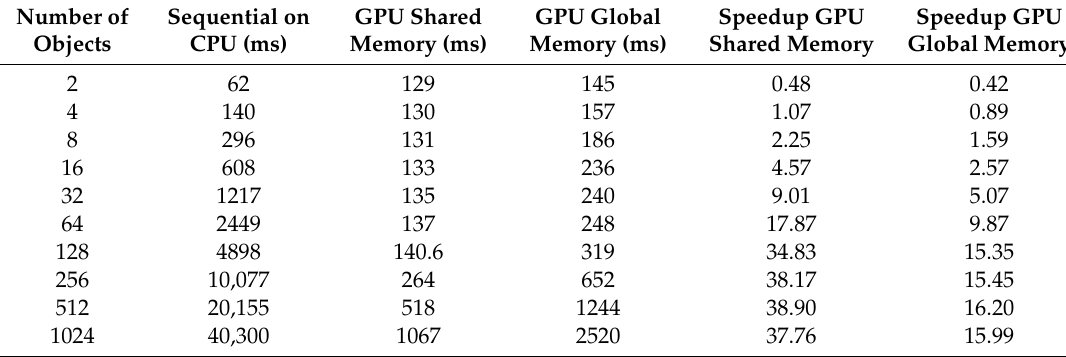
Table 2. Comparison of CPU and GPU performance for di ff erent numbers of objects inside each membrane for a model with 8192 membranes in algorithm 1 (Figure 3)